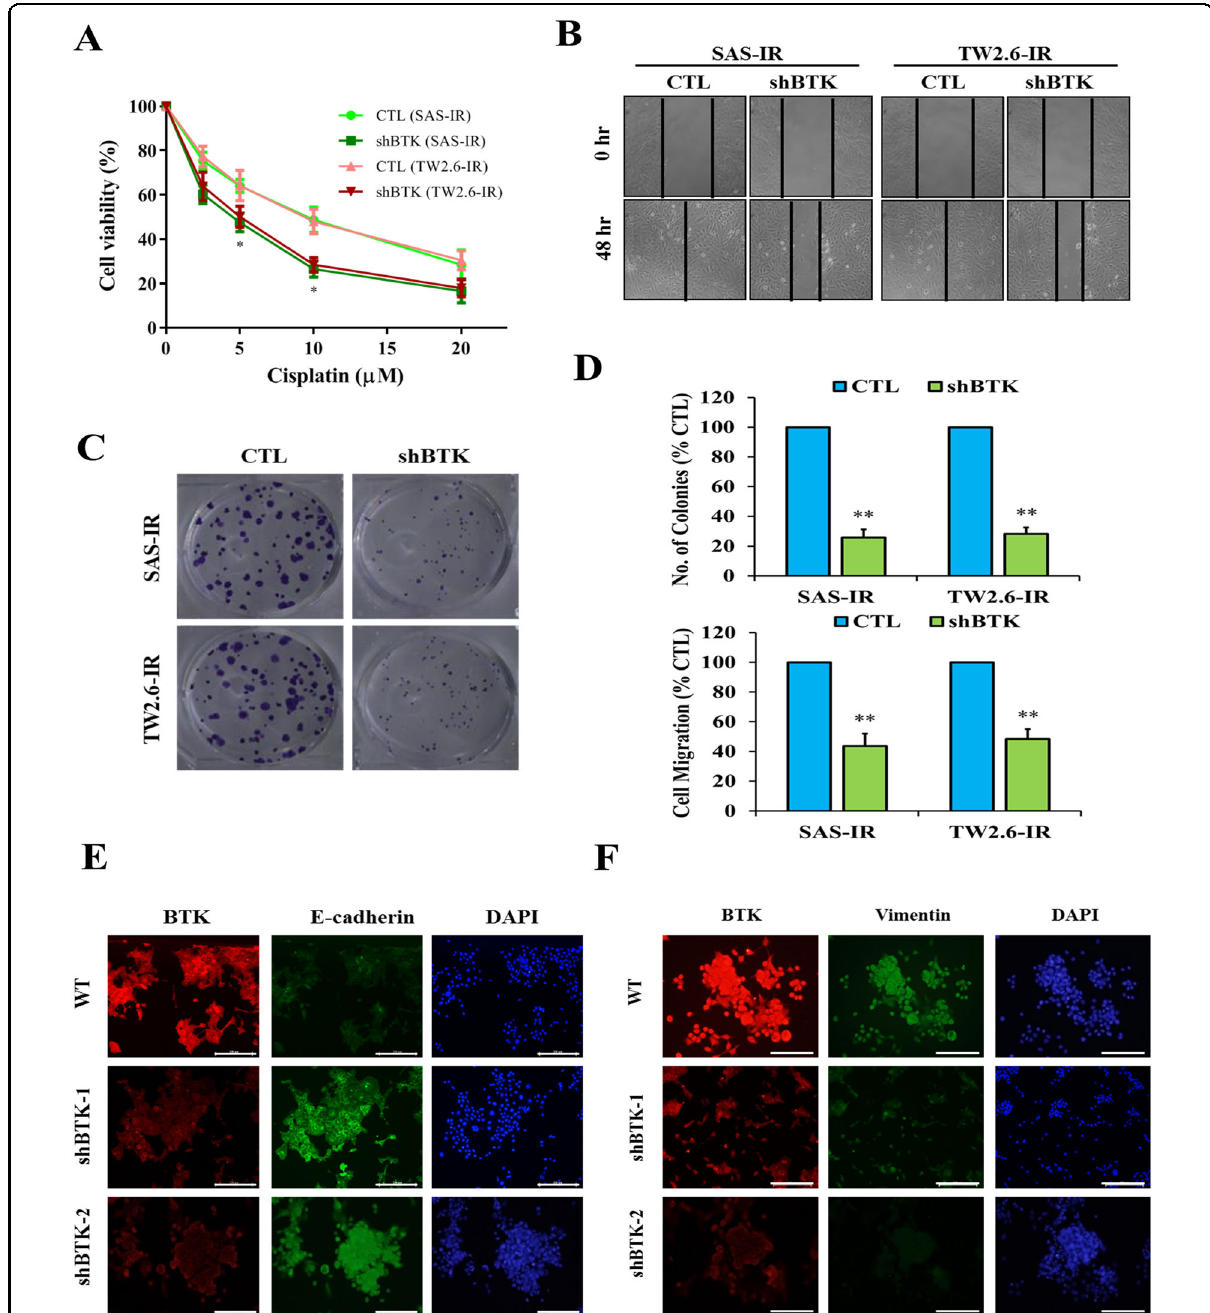
Fig. 3 BTK expression regulates viability and the metastatic trait of OSCC cells. A Cell viability curve for the SAS/-IR and TW2.6/-IR cell line at 48 h of treatment with dose-dependent of cisplatin. B BTK-KD cells exhibited slower area closure than WT cells in the in vitro scratch wound cell migration assay after 48 h. C BTK-knockdown signi fi cantly decreased colony-forming abilities. D The quantitative data of the two types of cells. E , F Immuno fl uorescence staining images showing the BTK expression, E-cadherin, and vimentin in SAS-IR WT and SAS-IR cells transfected with shBTK. DAPI, nuclear staining. All assays were performed at least twice in triplicate and expressed as mean ± SD. * p < 0.05, ** p <